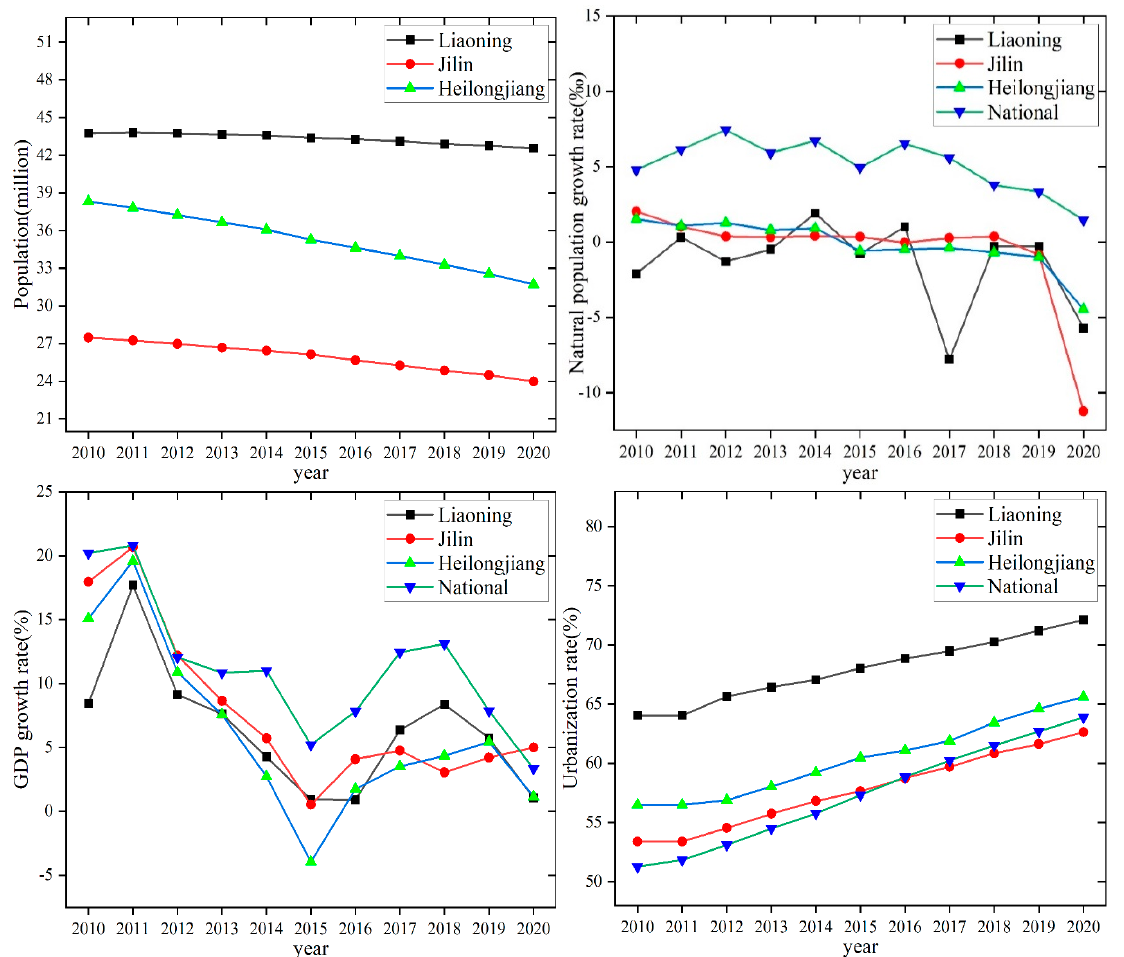
Figure 5. Changes in total population, natural population growth rate, GDP growth rate, and urbanization rate in the NCF.